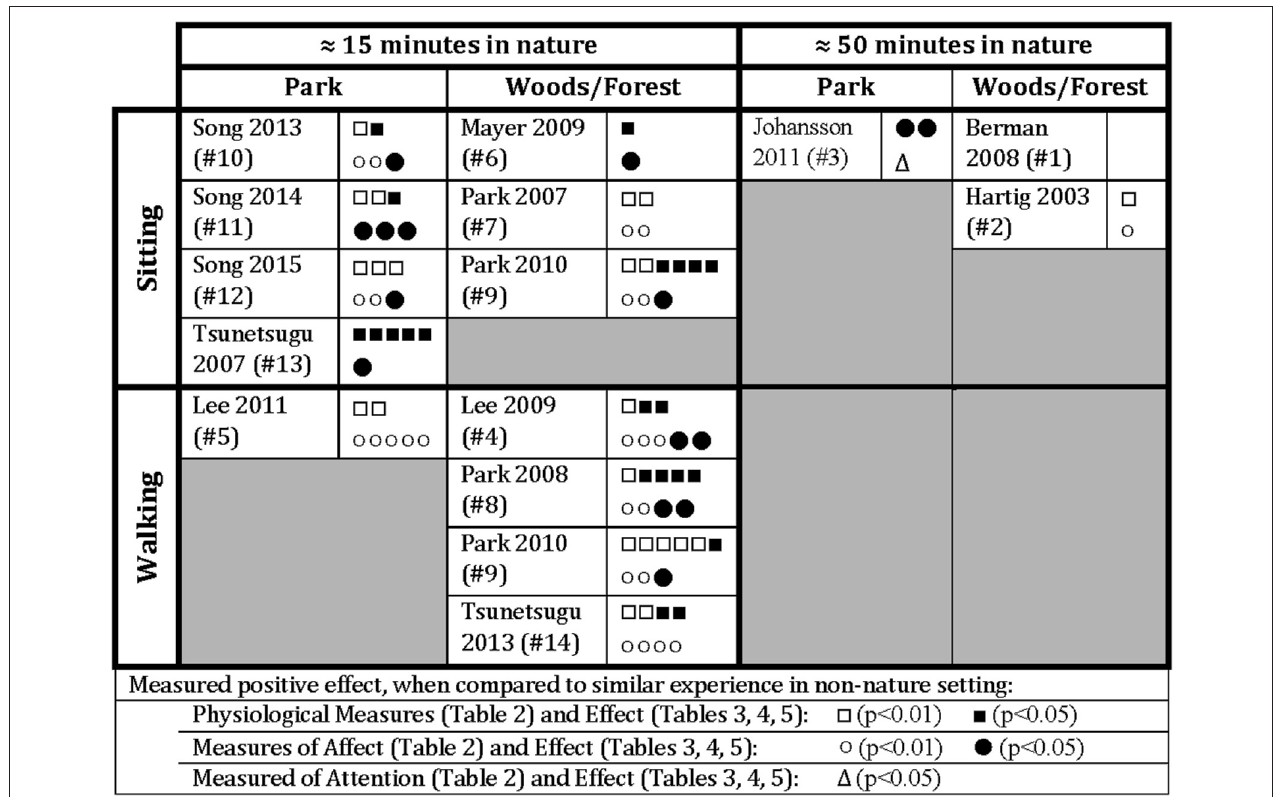
FIGURE 2 | Reported effects or benefits of time in nature, as compared to similar experience in non-nature setting (summary of data from Tables 3 – 5